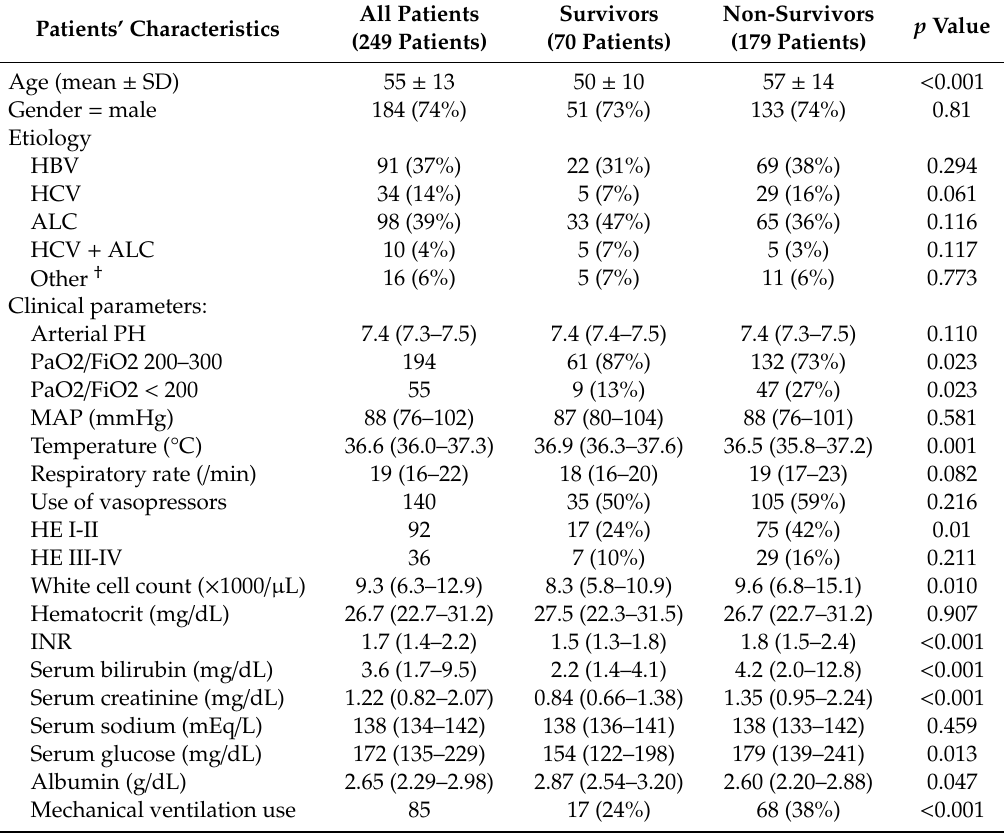
Table 1. Demographics of 249 patients with acute-on-chronic liver failure (ACLF) admitted to the intensive care unit